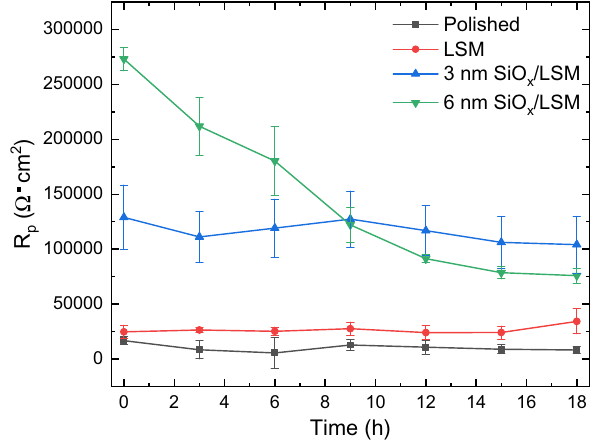
Fig. 7 Polarization resistance as a function of time of immersion for the different samples